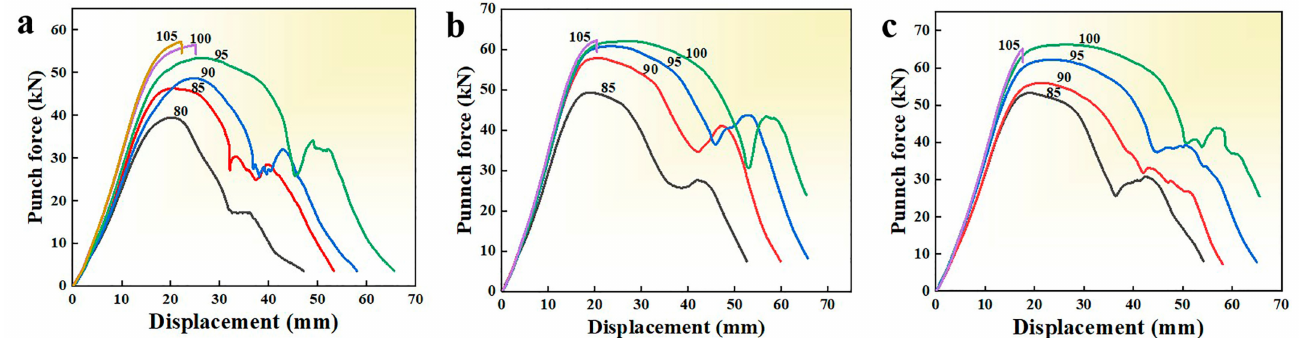
Figure 5. Punch-force-displacement curves of Ti/Al multilayered composites with ( a ) three layers, ( b ) five layers, and ( c ) seven